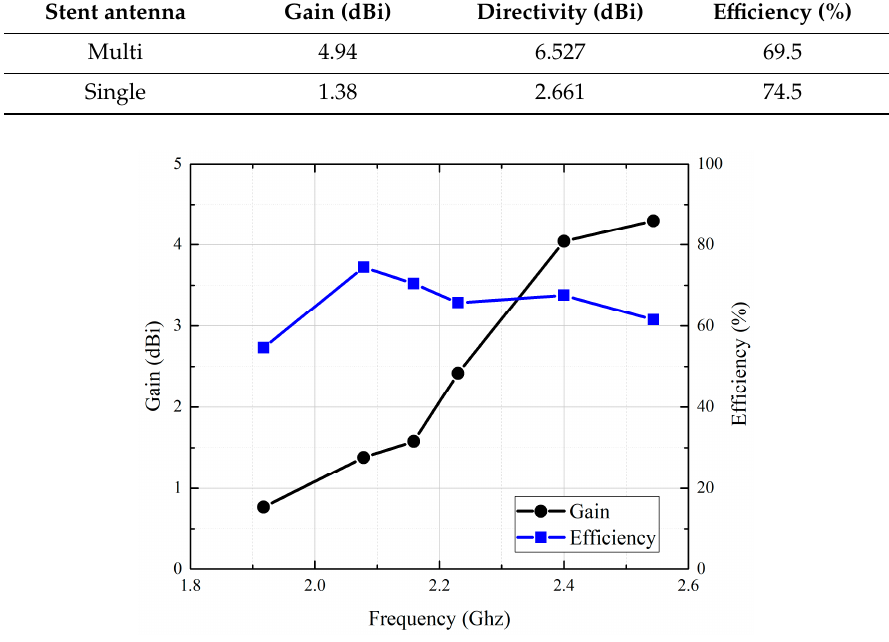
Figure 16. The measured gain and radiation efficiency of the single-connector stent antenna.